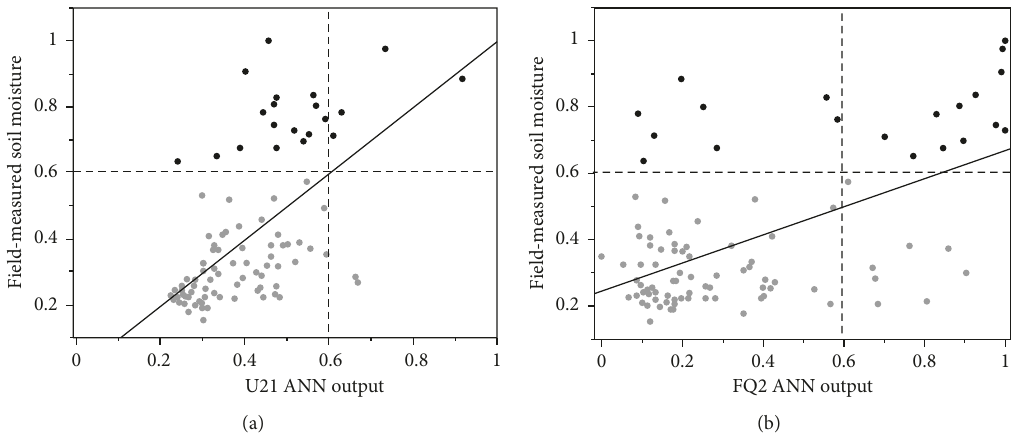
Figure 15: Comparison of incidence angle effects when modelling high soil moisture ( θ Observatory, July 23, 2010. Here, the U21 and FQ2 scenes have average incidence angles of 45.4 ° and 20.9 ° , respectively. Field-measured soil moisture values where volumetric water content was greater than 0.60 (i.e., θ v 0.60) are presented in grey. Dashed lines indicate where θ v (i.e., θ v <